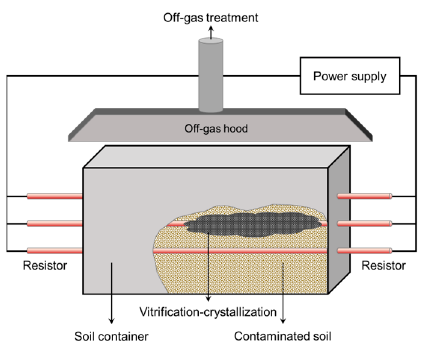
Figure 2. Schematic diagram of electrical resistance heating device.